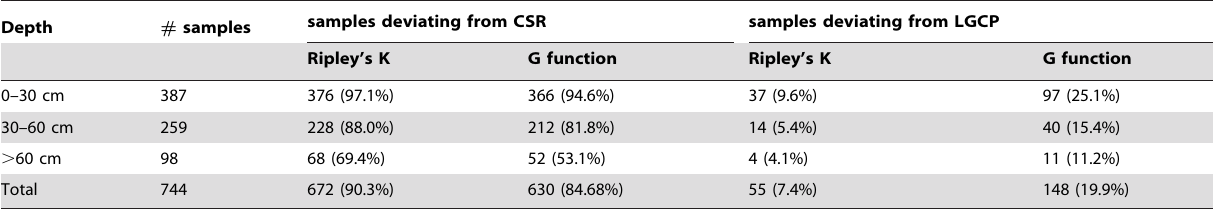
Table 2. Total number of samples, number (proportions %) of samples deviating from CSR and number (proportions %) of samples deviating from the LGCP model for different soil depths for all bacterial distribution having more than 5 bacterial cells in the field of